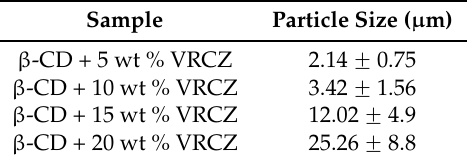
Table 1. Particle sizes of β -CD complexes loading with Voriconazole (VRCZ).